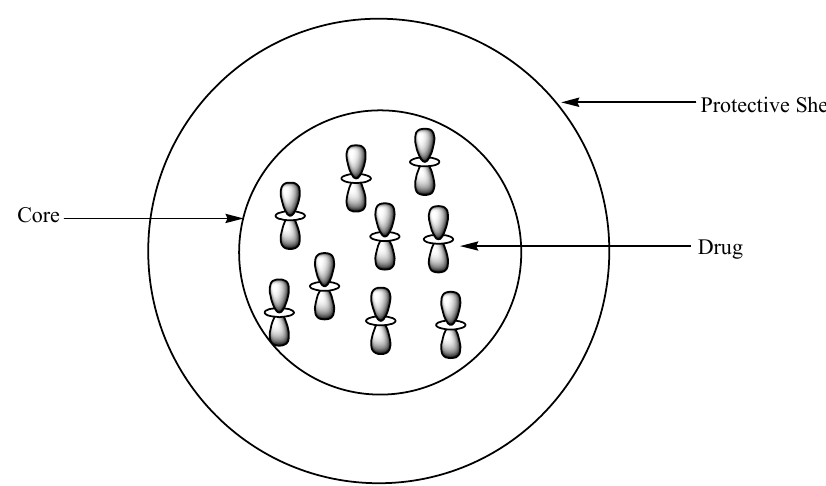
Figure 21. Schematic diagram showing polymer-encapsulated drug.